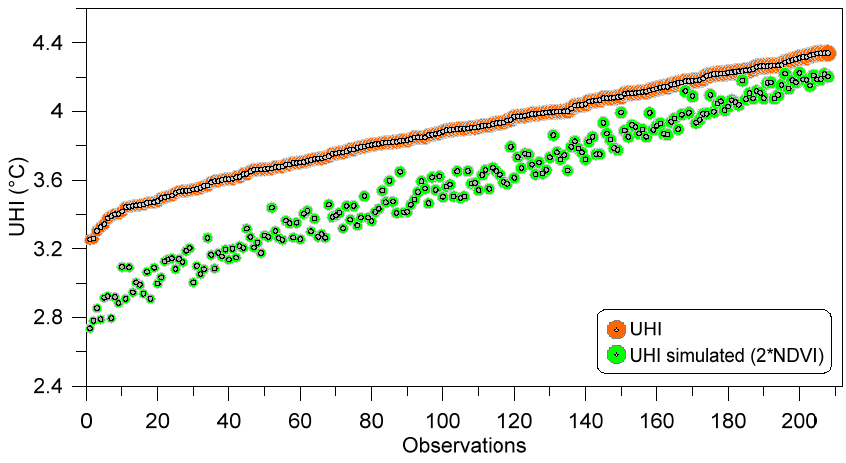
Figure 12. Maximum UHI and maximum simulated UHI with NDVI increased by 100%. After a simulation of UHI with the NDVI increased by twice the simulated UHI, the area decreased by 45% (from 94,296 m 2 to 51,931 m 2